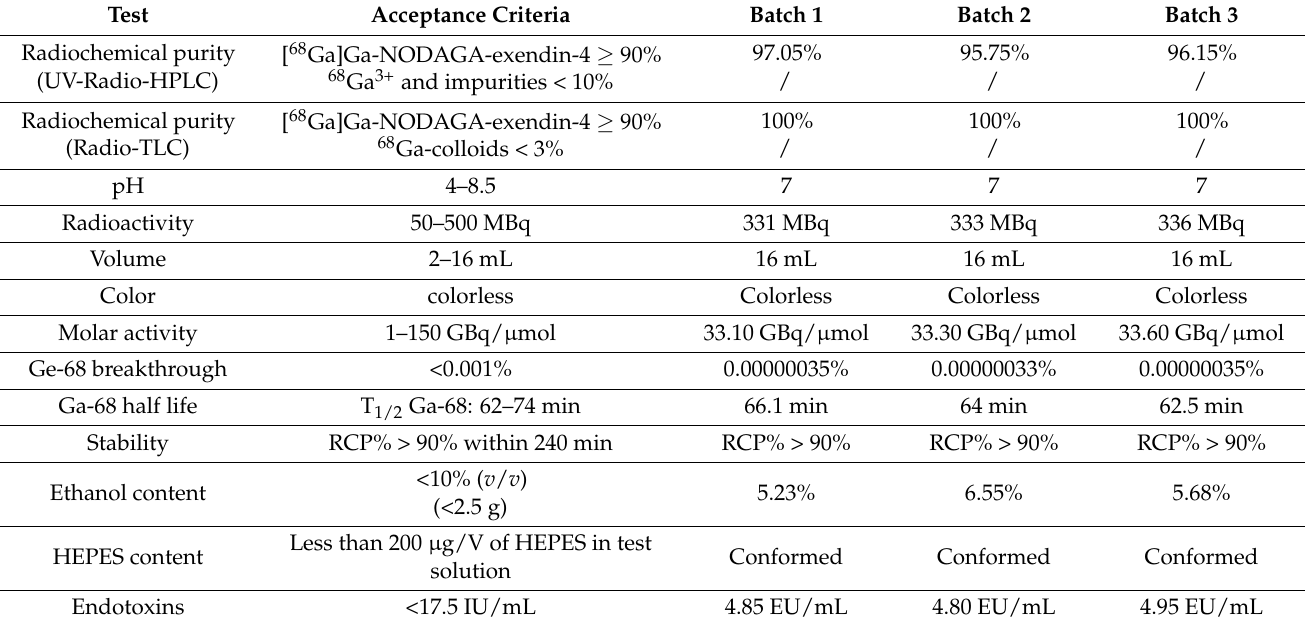
Table 3. Summary of acceptance criteria and QC results calculated for all three validation batches of [ 68 Ga]Ga-NODAGA-exendin-4, obtained from 10 µg of precursor.